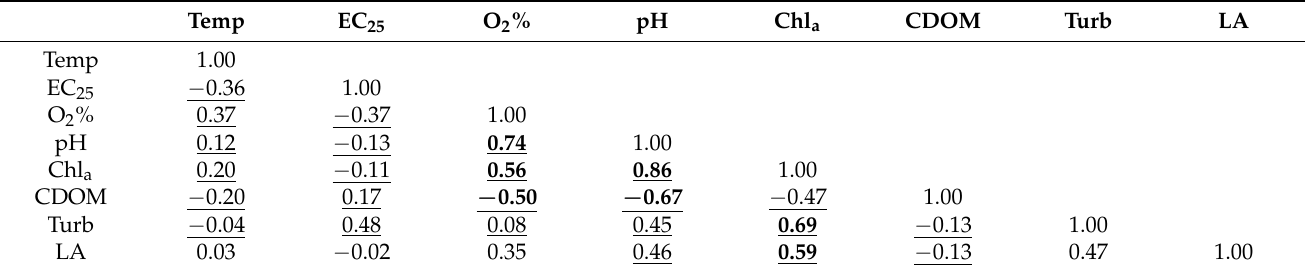
Table 3. Correlation matrix of eight physicochemical BIOFISH parameters. Underlined values represent that correlation is significant at the 0.05 level. Due to the high number of samples (n = 2152), even correlations with very low Pearson’s r have p -values below 0.05. Correlations with a Pearson’s r greater than 0.5 are therefore bold.